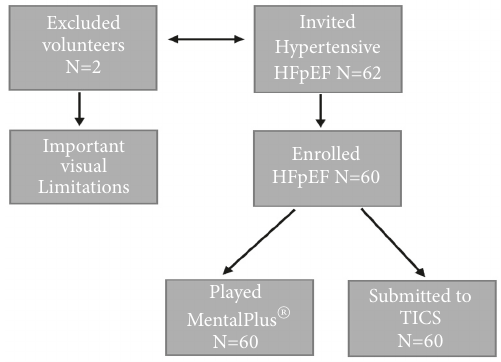
Figure 1: Study fluxogram. HFpEF: heart failure with preserved ejection fraction; MentalPlus (cid:2) : Open Tool Virtual Game; TICS: Telephone Interview Cognition